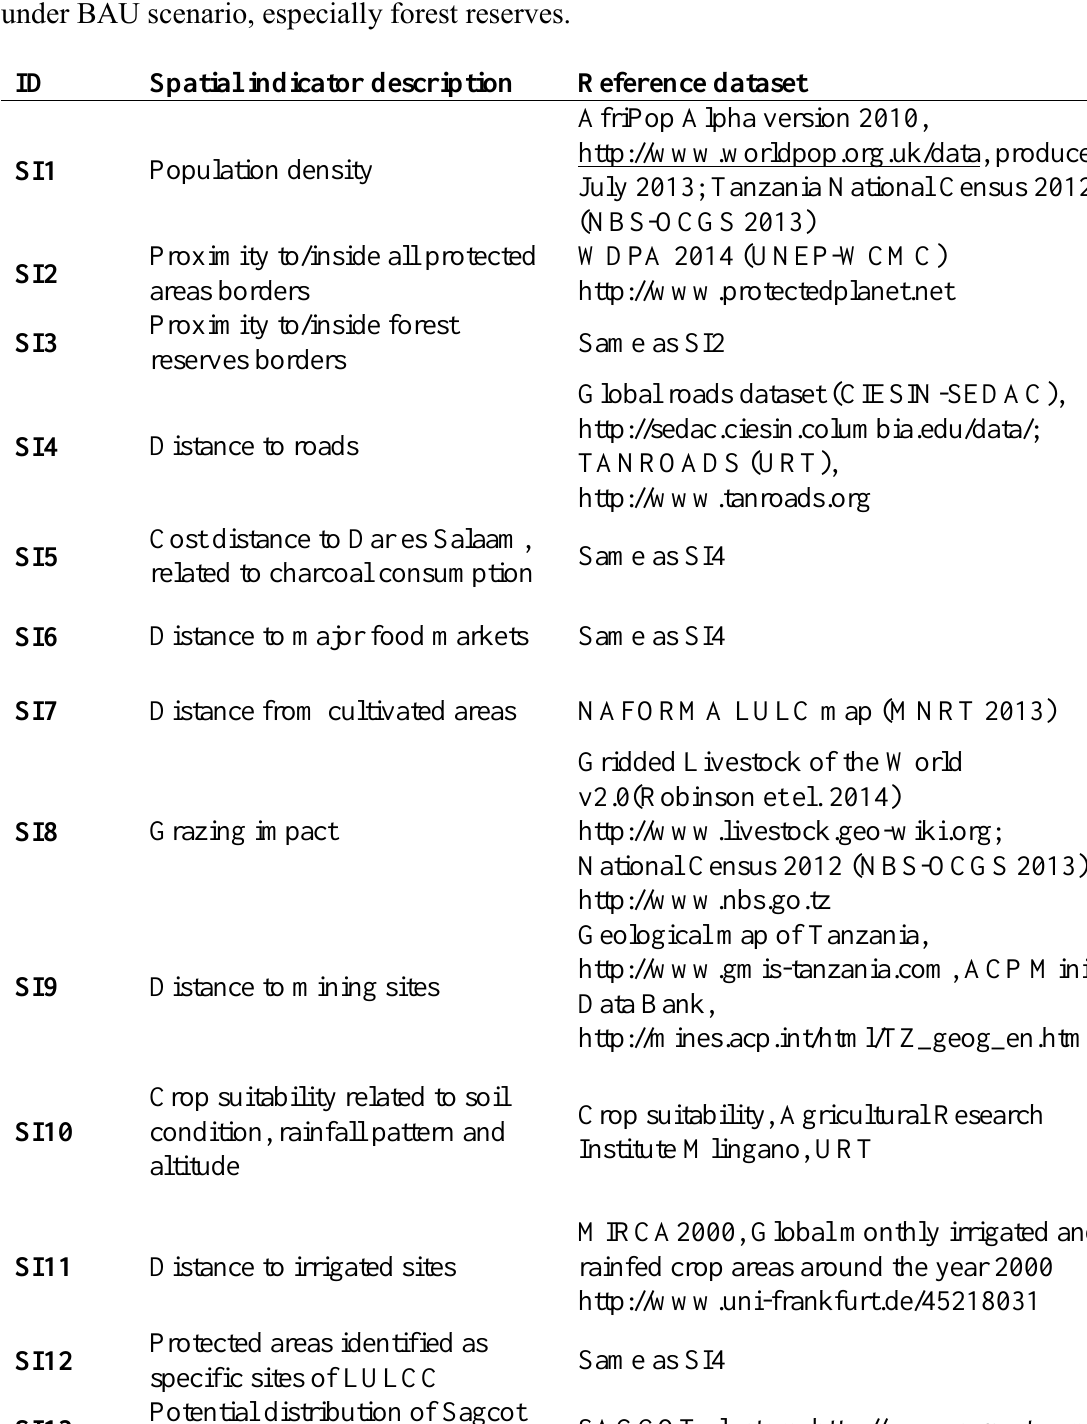
Table A2.2: Indicators of spatial distribution of potential future LULCC identified during stakeholders workshops and the spatial datasets selected to represent them. Stakeholders reported biophysical factors (SI1 - SI11) favouring LULCC and specific sites where those were most likely to occur (SI12 - SI14). Factors limiting changes were also simulated (SI14 - SI18), in particular for protected areas. Participants acknowledged the role of those sites in habitat conservation, but they also expected LULCC occurring near or inside their borders under BAU scenario, especially forest